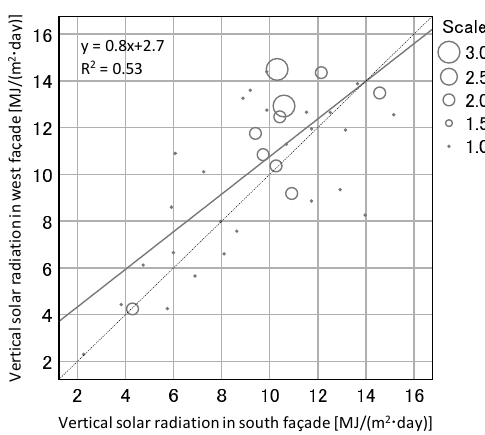
Figure 8. The relation between the vertical solar radiation in the west and south façade in the last 10 years in the investigated area [33].